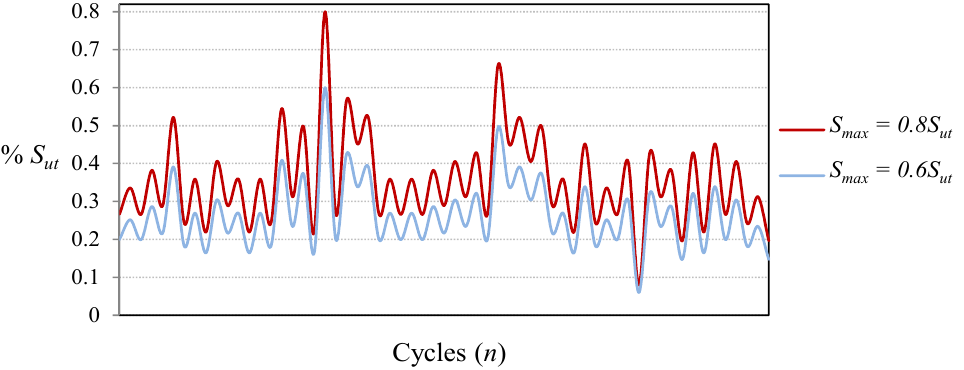
Figure 4. Fraction of Falstaff showing load sequences of different severity, with maximum peak loads of 0.8 S ut and 0.6 S ut .